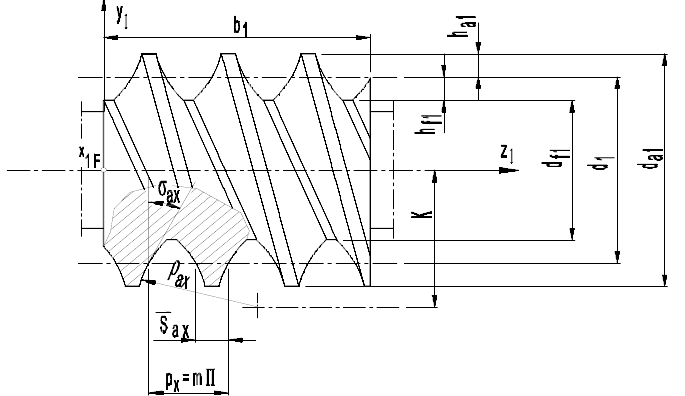
Figure 3. The cylindrical worm with a circle arc profile in axial section with the profile parameters, as the distance K between the arc center and the worm axis, and the arc radius ρ ax at standard marks, which has been patented [11,17–19,24].